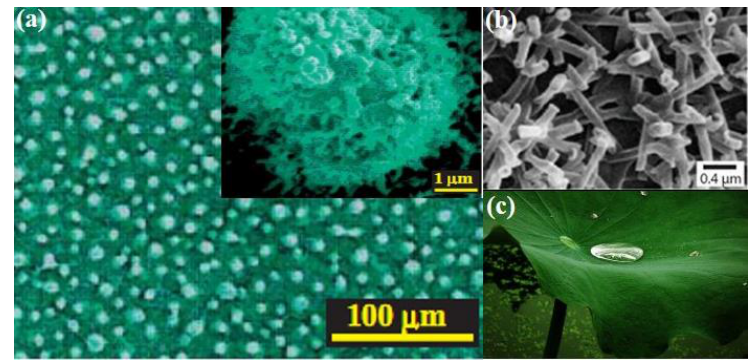
Figure 7. Micro–nanoscale composite structures of Lotus leaf surface: ( a ) Natural lotus leaf surface structure; ( b ) Biomimetic composite structure. (Reproduced from [82] with permission; Copyright 2002 Wiley). ( c ) The droplet on the lotus leaf surface.